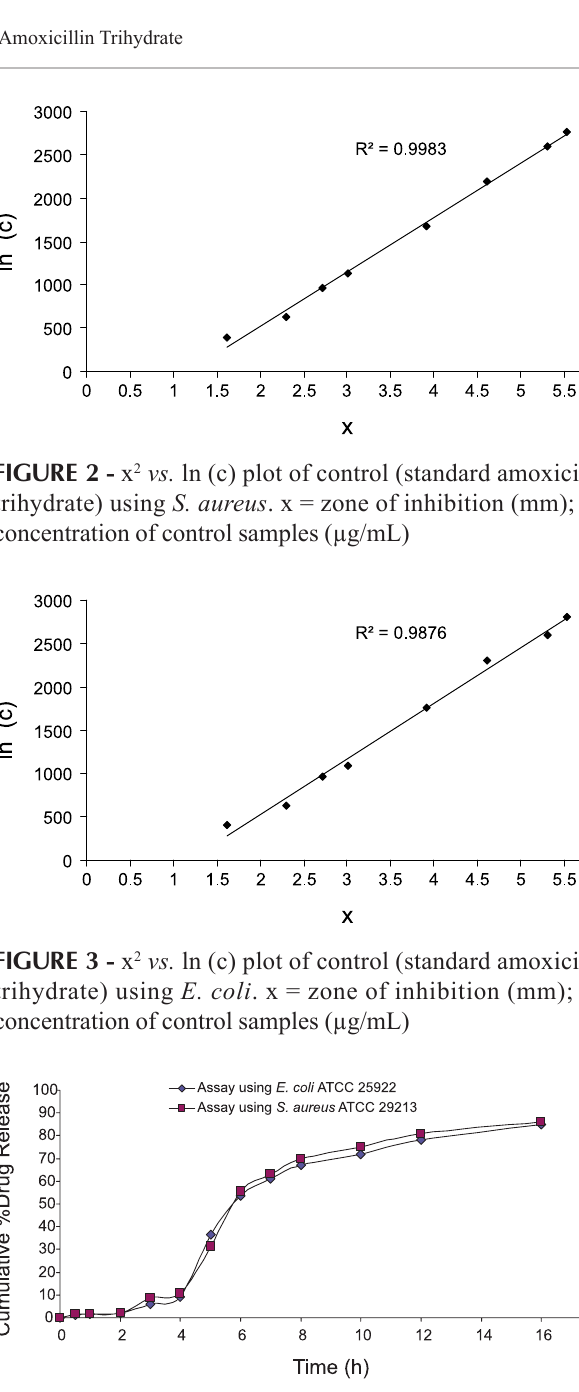
FIGURE 4 - Comparative in vitro drug release profiles of optimized time-dependent release bilayer tablet containing AMT using S. aureus and E. coli as test